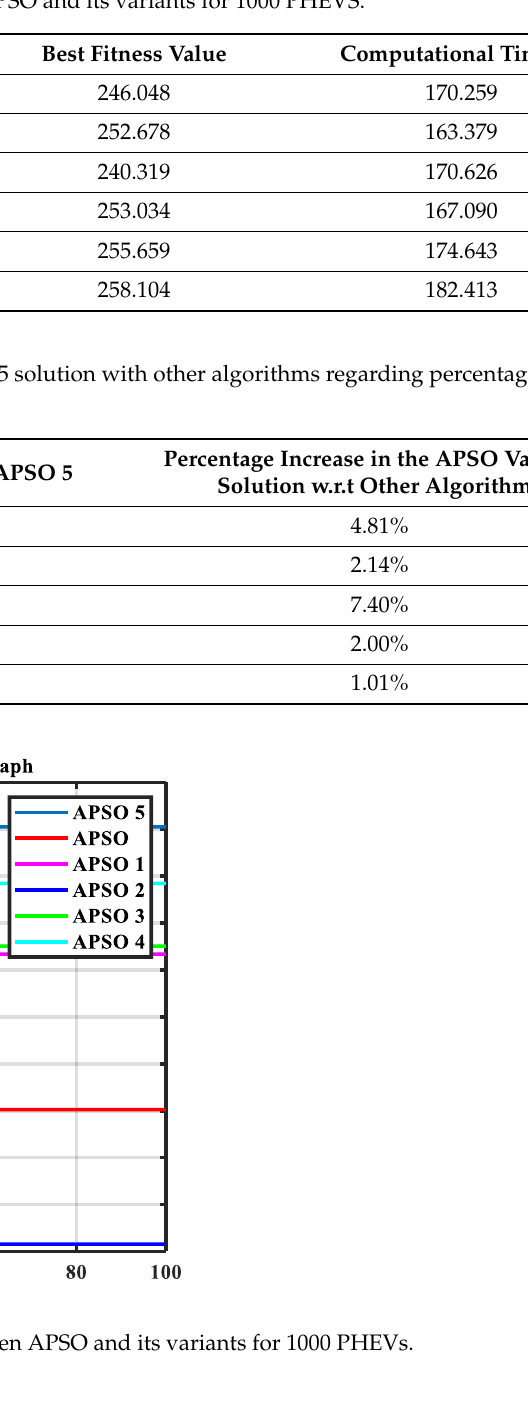
Table 15. Summarized results for APSO and its variants for 1000 PHEVS.